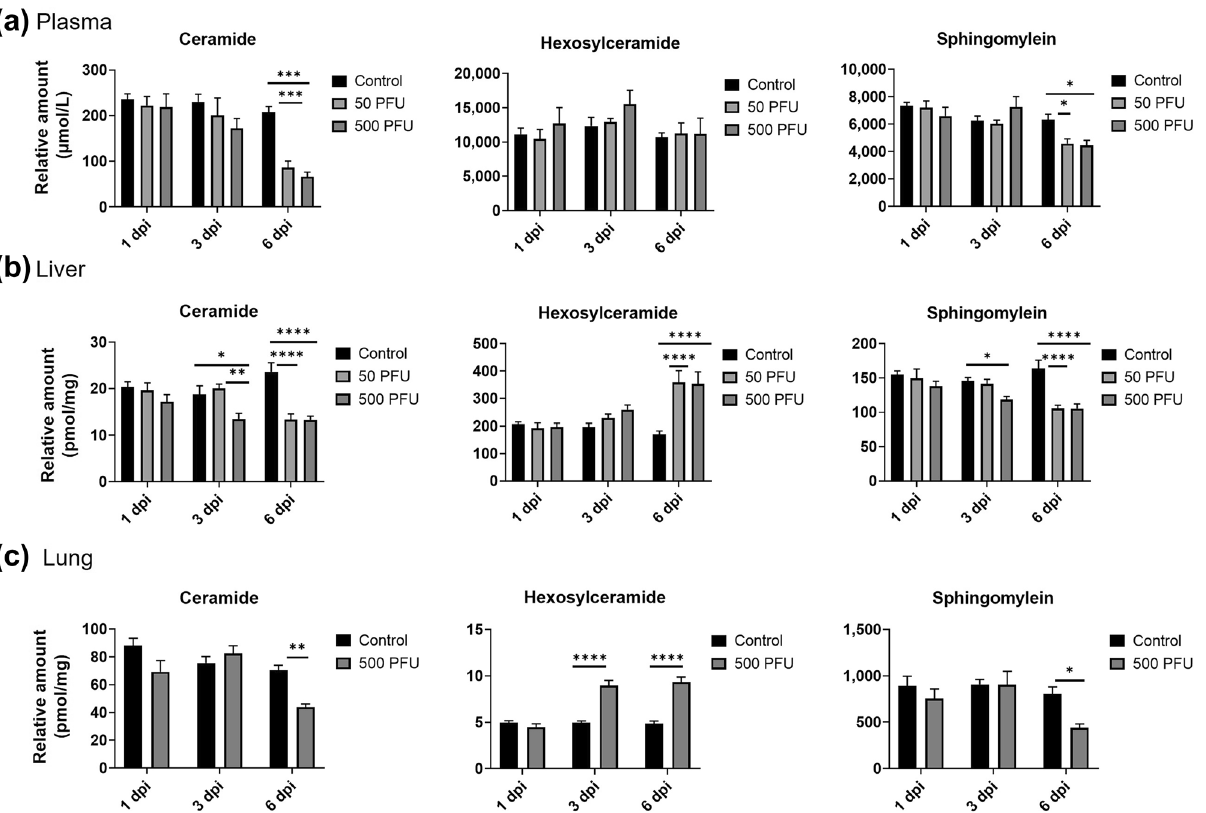
Figure 4. Relative concentrations of total ceramide, hexosylceramide and sphingomyelin in plasma ( a ), liver ( b ), and lung ( c ) of PR8 virus infected mice (n = 5 each, mean ± SE, 2way ANOVA with Tukey’s multiple comparison test, * p < 0.05, ** p < 0.005, *** p <